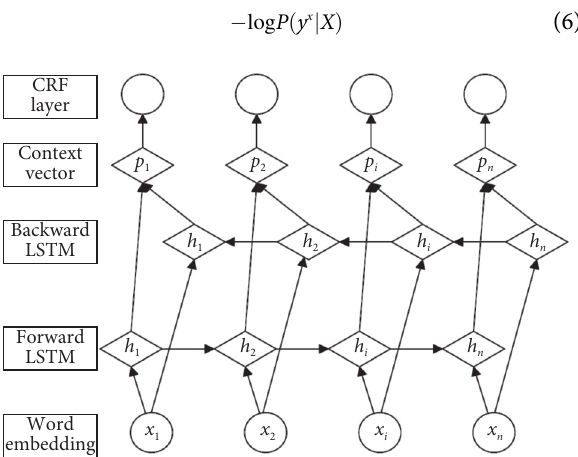
Fig. 2 Structure diagram of the word skipping model. Fig. 3 Structure diagram of the BiLSTM-CRF